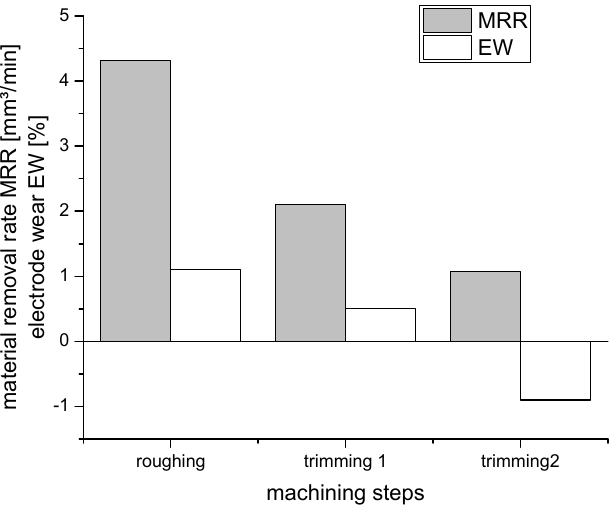
Figure 5. Material removal rates MRR and electrode wear ratios EW of different machining steps.